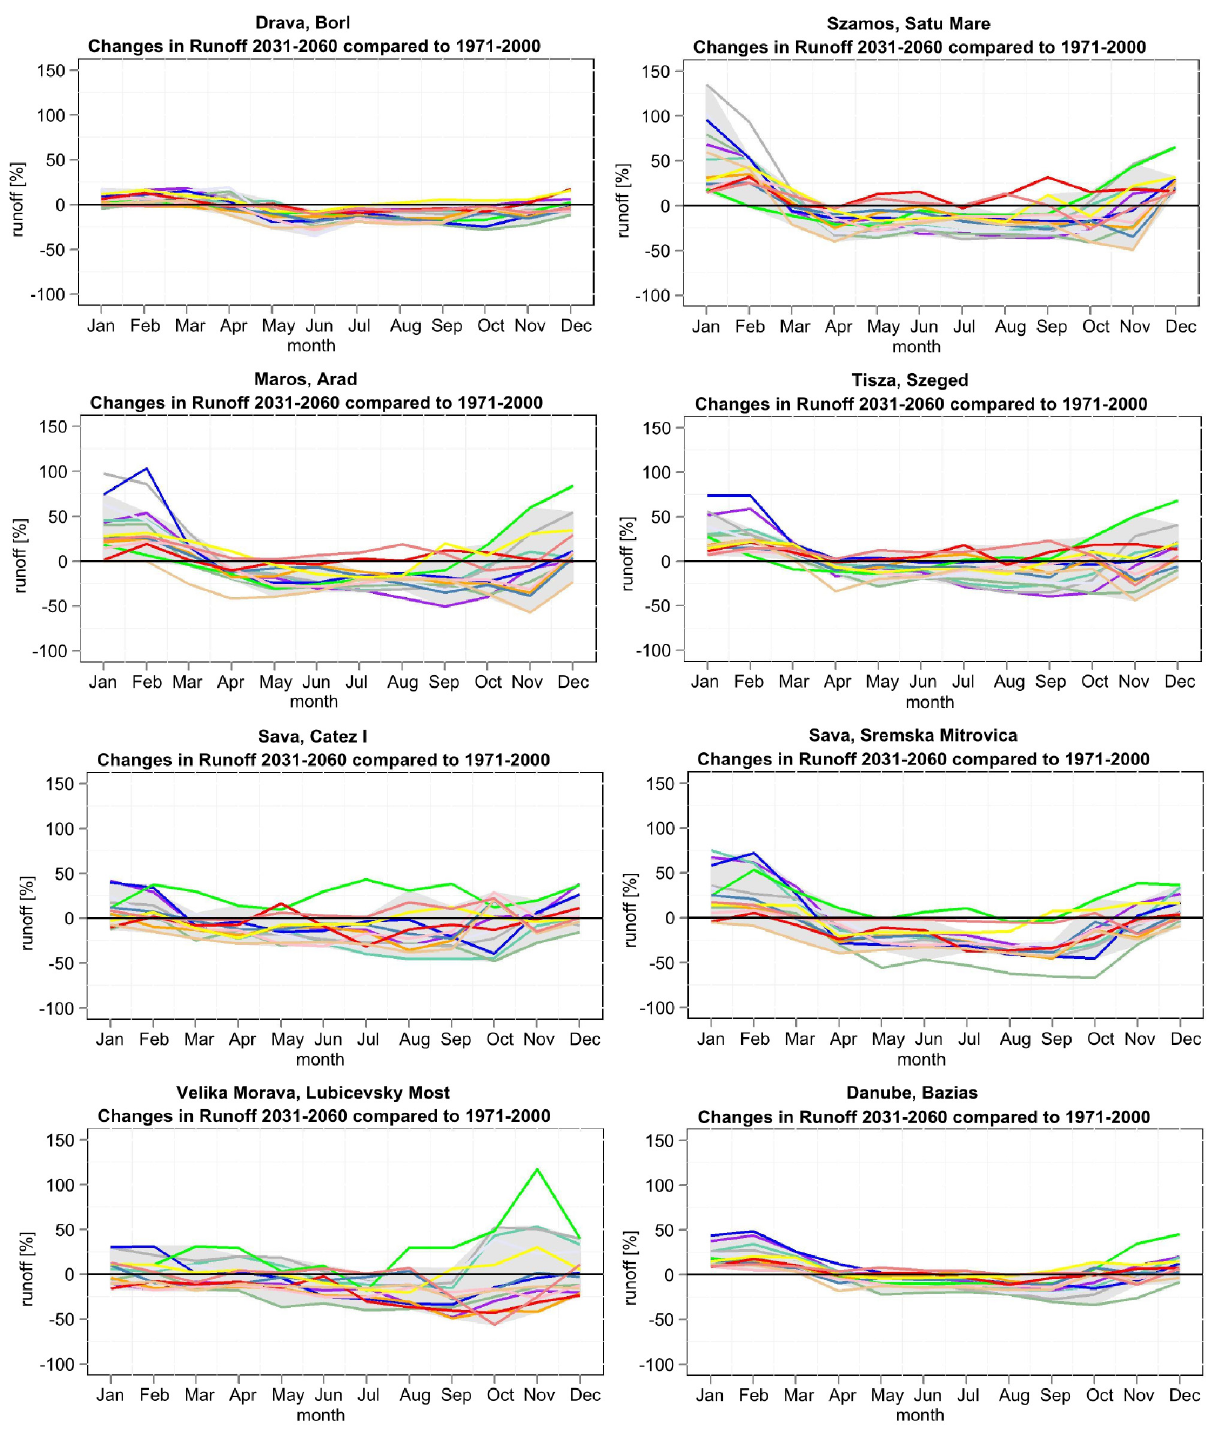
Figure 11. Changes (%) in the mean runoff seasonality between the reference period 1971–2000 and the near future scenario period 2031–2060 for selected stations in the Middle Danube River catchment. The grey ribbon comprises the range of results without